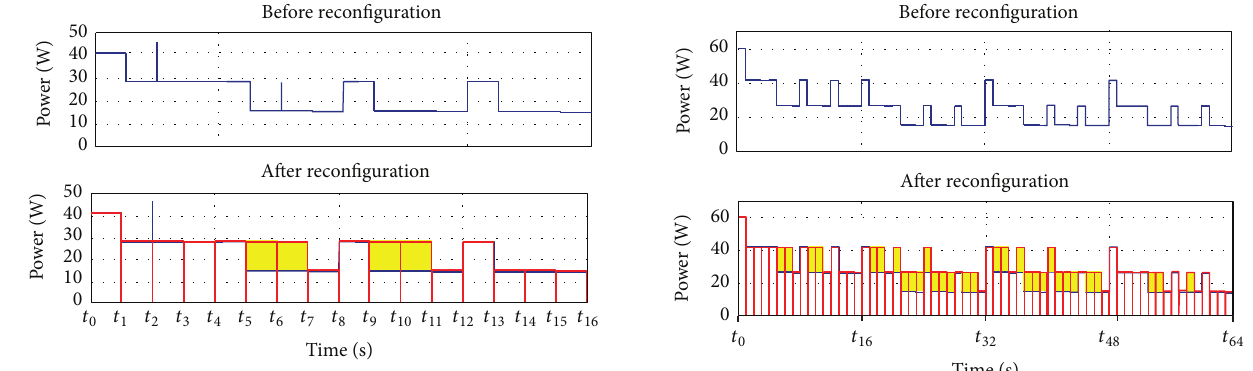
Figure 10: Power versus time curve for a 2×3 array and progressive shading (before and after